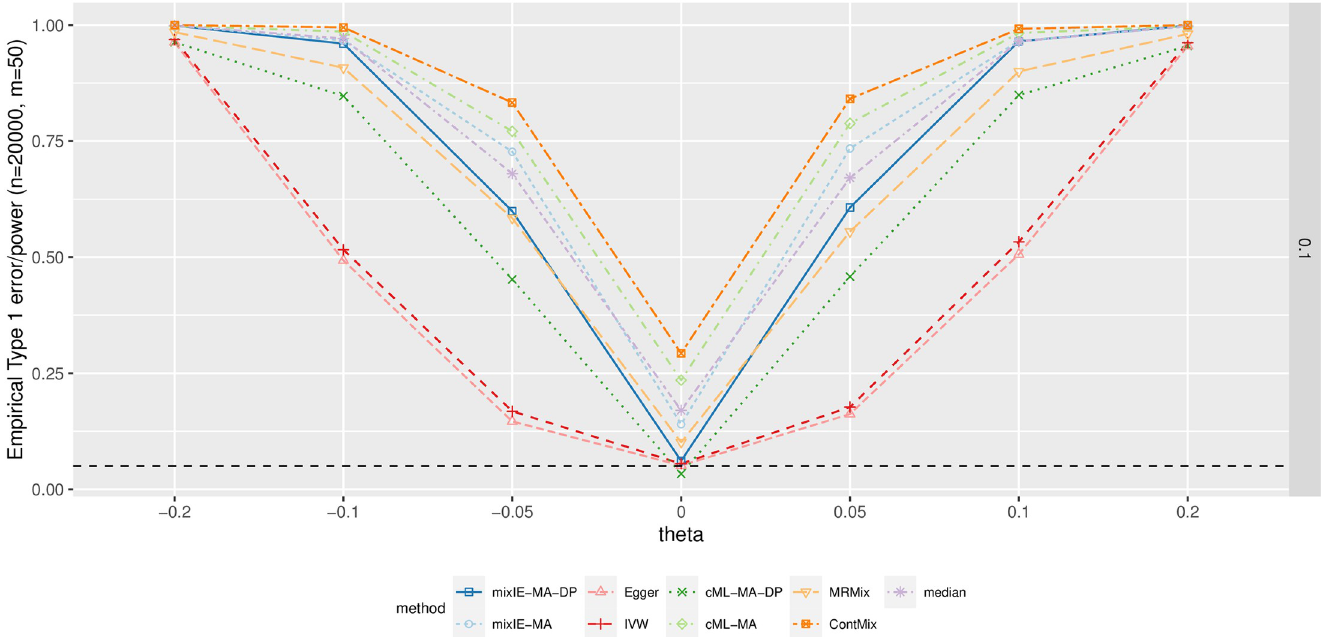
Fig 9. Simulation results with many invalid IVs having weak pleiotropic effects. Empirical type-I error (for θ = 0) and power (for θ 6¼ 0) curves with sample size n = 20000 and h y =